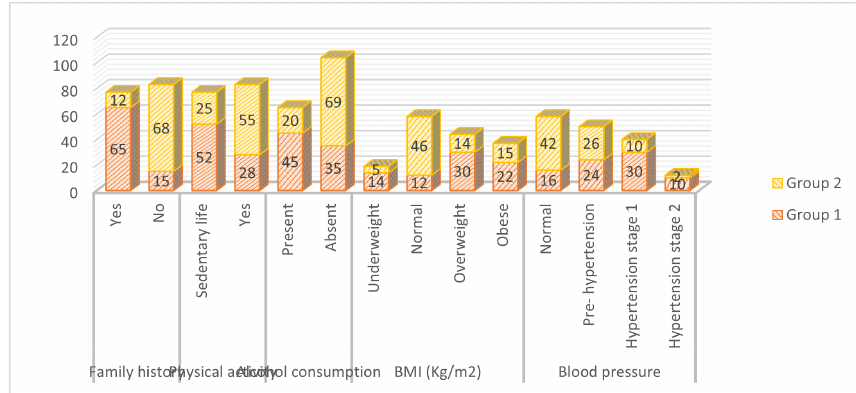
Figure 1. Patient